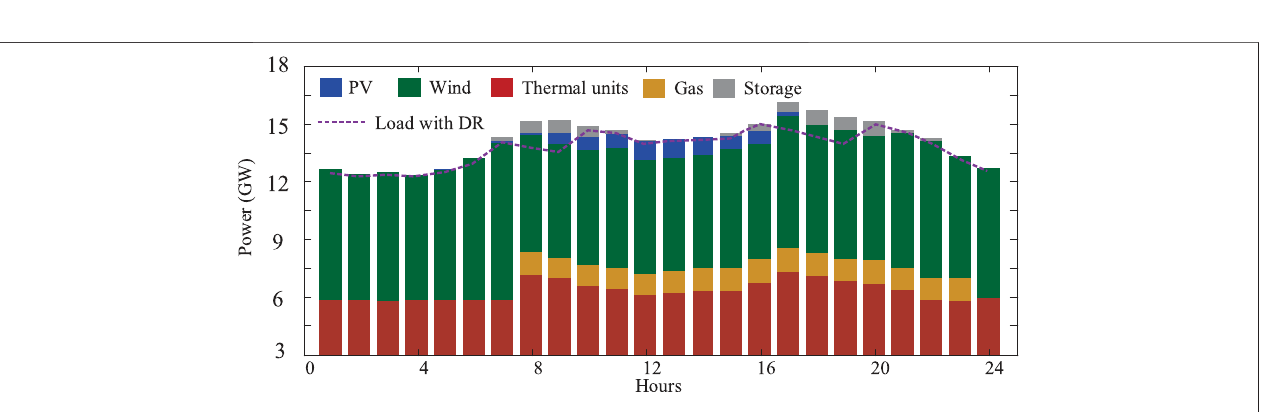
FIGURE 6 | Power components of the Heilongjiang power grid on a typical winter day in carbon reduction ++ scenario.